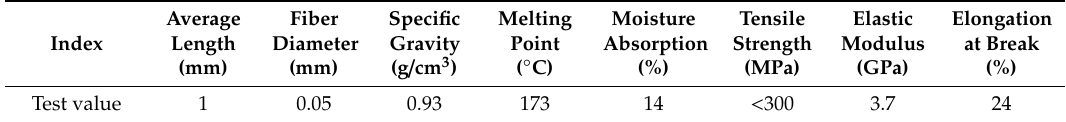
Table 5. Technical properties of the test